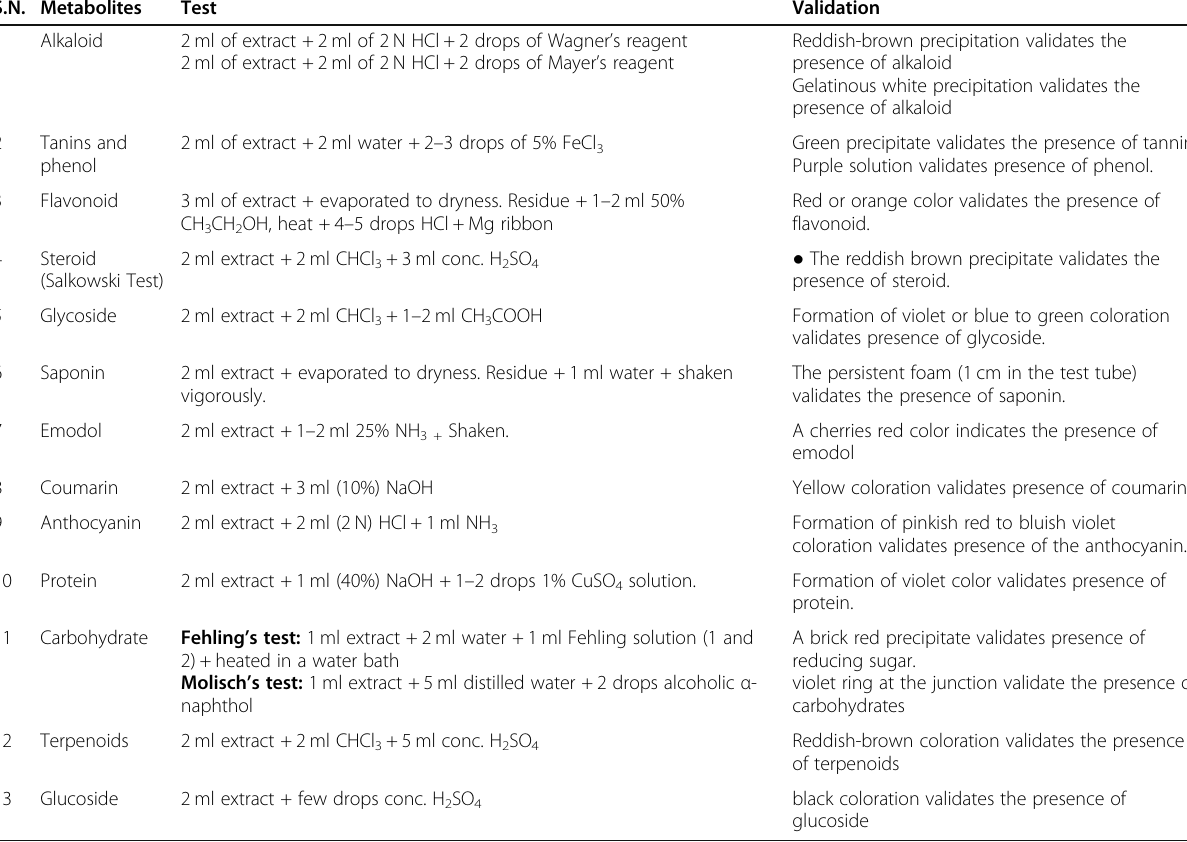
Table 1 Preliminary phytochemical tests for plant extracts S.N. Metabolites